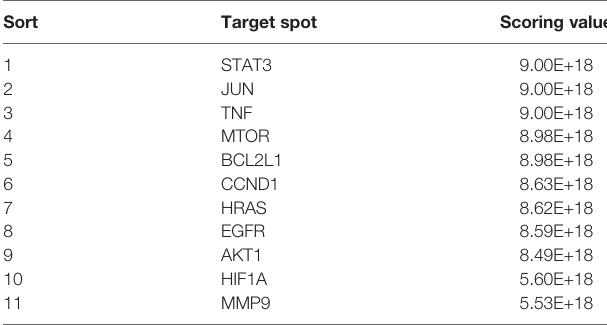
TABLE 2 | Apoptosis-related targets in lung cancer